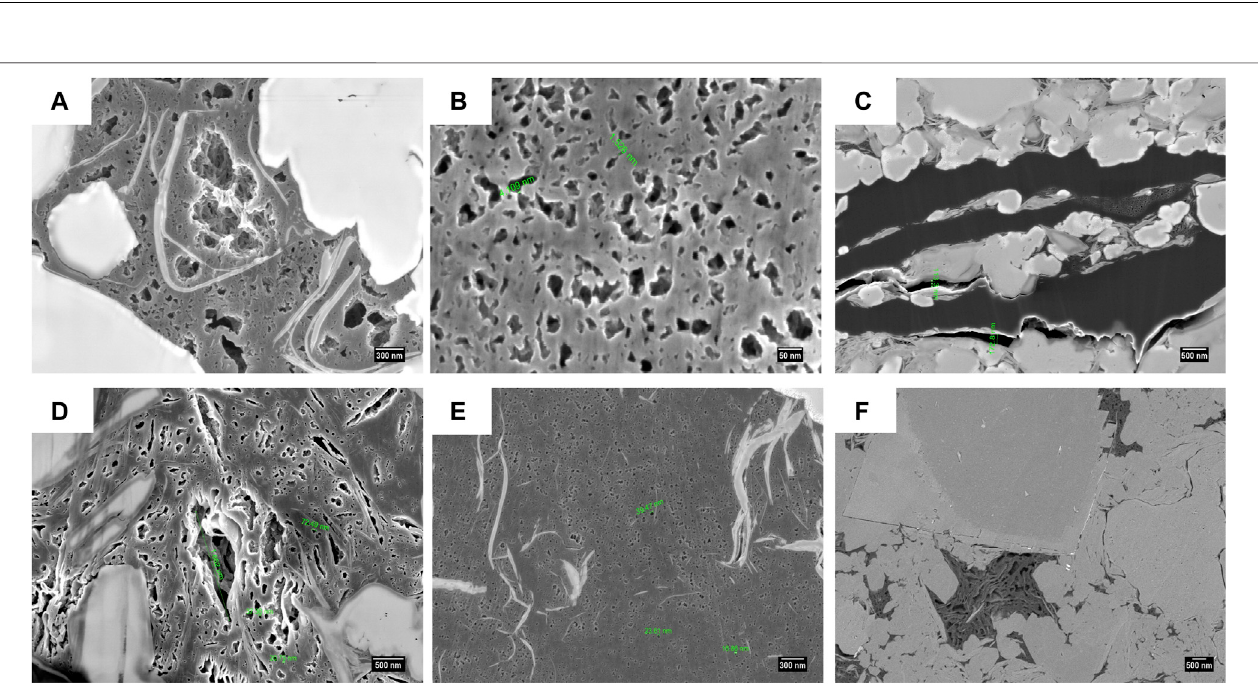
FIGURE 10 | Matrix pore characteristics of selected samples. (A , B) Sample JY9, siliceous shale, various sizes of OM pores showing that large pores are interconnected with small pores. (D , E) Sample WY23-6-6, mixed shale, various sizes of OM pores in different OM from μ m to approximately 20 nm. (C) Microfractures along banded organic matter in sample WY23-6-6. (F) InterP pores with carbonate grains observed in sample WY23-6-6.